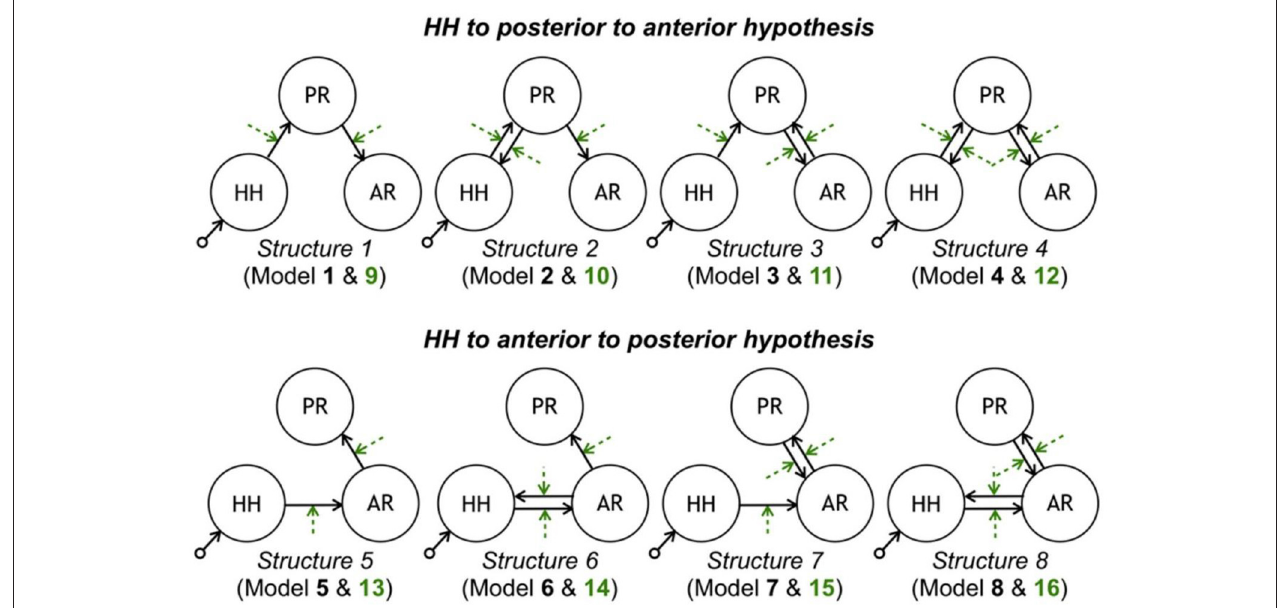
FIGURE 8 | Model space tested with DCM. Each row contains eight models consistent with each propagation hypothesis. Each column corresponds to a different latent connectivity structure. For each latent connectivity structure, the linear model is presented with solid arrows and the bilinear model is presented with solid arrows (intrinsic connections) and dashed arrows (connections’ modulation). Seizure activity is fed into the HH network node